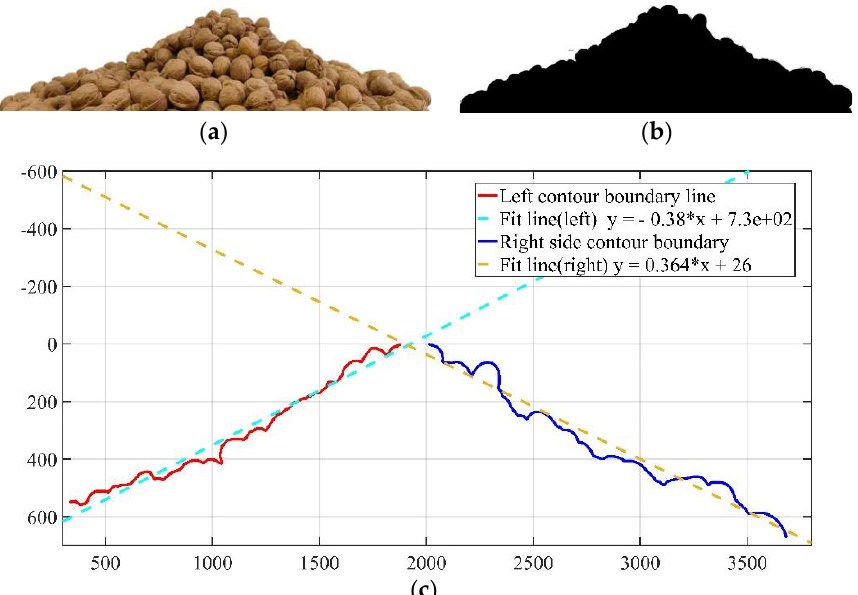
Figure 3. The stacking angle acquisition of walnuts. ( a ) Physical test diagram of the walnut diagram; ( b ) Grey processing diagram of the walnut stacking angle; ( c ) Profiles of the walnut stacking angle and fitting diagram.